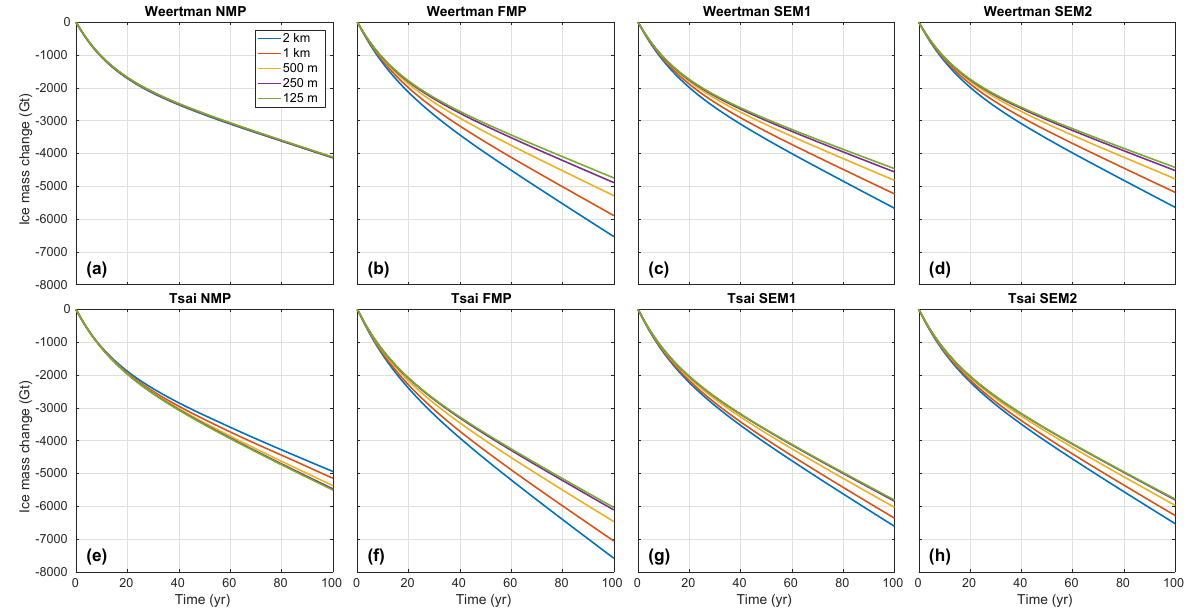
Figure 6. Evolution of ice volume above floatation in experiment 2 for the NMP (a, e) , FMP (b, f) , SEM1 (c, g) , and SEM2 (d, h) for the Weertman (a–d) and Tsai (f–h) friction laws. Each plot represents the evolution for the five mesh resolutions: 2km (blue), 1km (red), 500m (yellow), 250m (purple), and 125m (green).